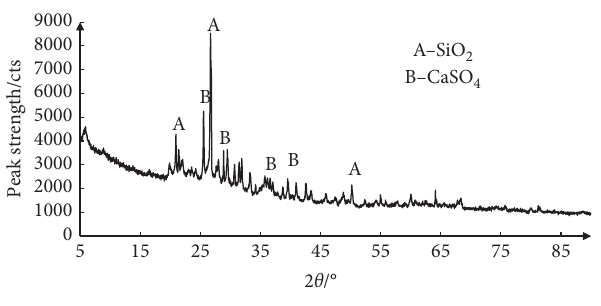
Figure 4: XRD of material